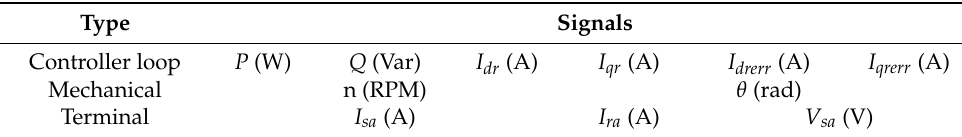
Table 2. Summary of the data signals